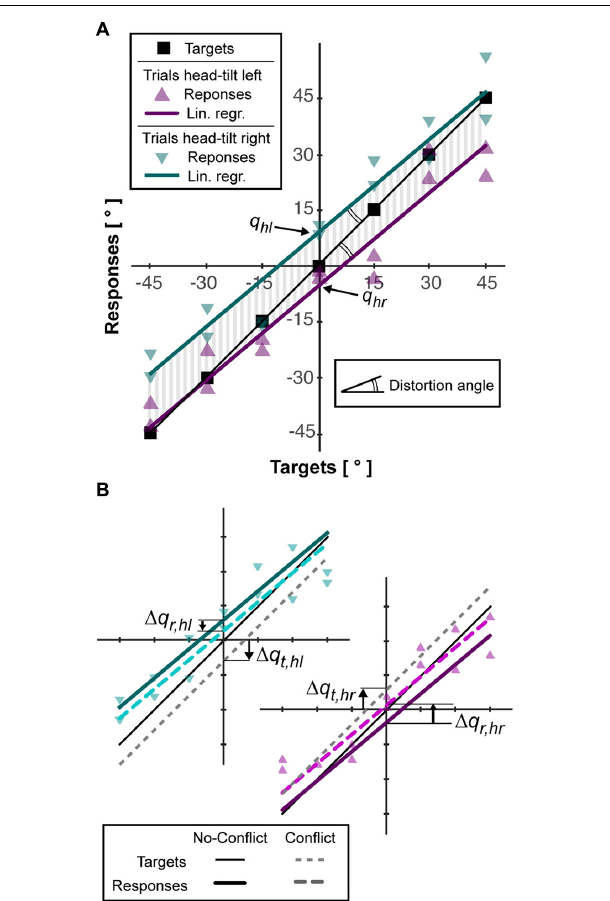
FIGURE 2 | Example of subject responses and associated analysis. (A) The responses for trials without conflict (triangles) are linearly interpolated as describe in “Materials and Methods” section (colored lines). The area (vertical gray bars) between each interpolation line and the line joining the targets (squares) is used to compute accuracy, Acc . The angle between the interpolation lines and the targets line is used quantify the distortion, Dist , of the responses. The intersections between the vertical axis and the lined interpolating the responses after left and right neck flexion ( q hl , q hr ) are used to quantify the response bias induced by the head roll (Aubert-Müller effect, AMe ). (B) For the trials with conflict, that is, rotation of the visual scene, the responses after left and right flexion of the neck are interpolated separately (see “Materials and Methods” section) and represented by dotted, colored lines. To estimate the relative importance given to the visual information, the vertical distance between the lines interpolating the response with and without conflict, (cid:49) q r , hl and (cid:49) q r , hr , is computed and compared to the theoretical deviation of the targets, if they assumed to move together with the visual scene, (cid:49) q t , hl and (cid:49) q t , hr